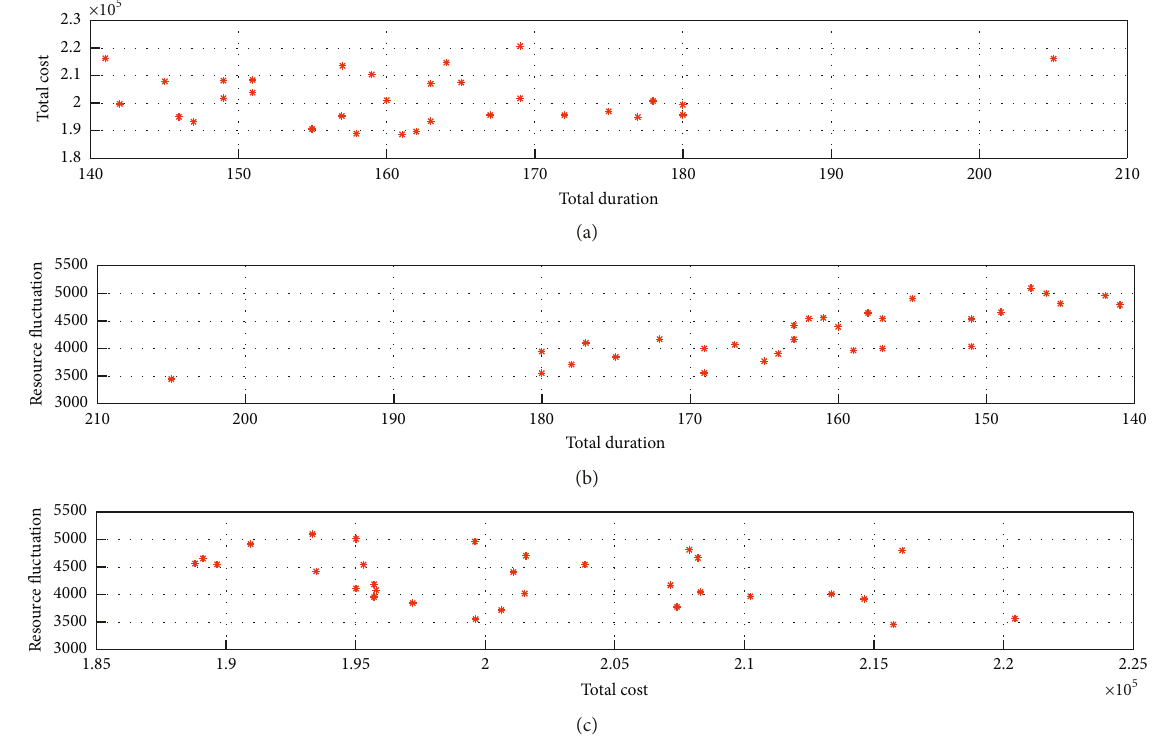
Figure 9: Optimal solutions in two-dimensional space.